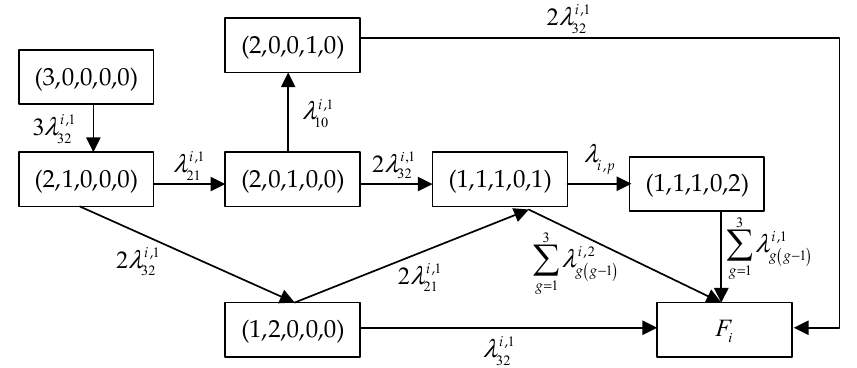
Figure 4. State transition diagram of the Markov process for the subsystem i .